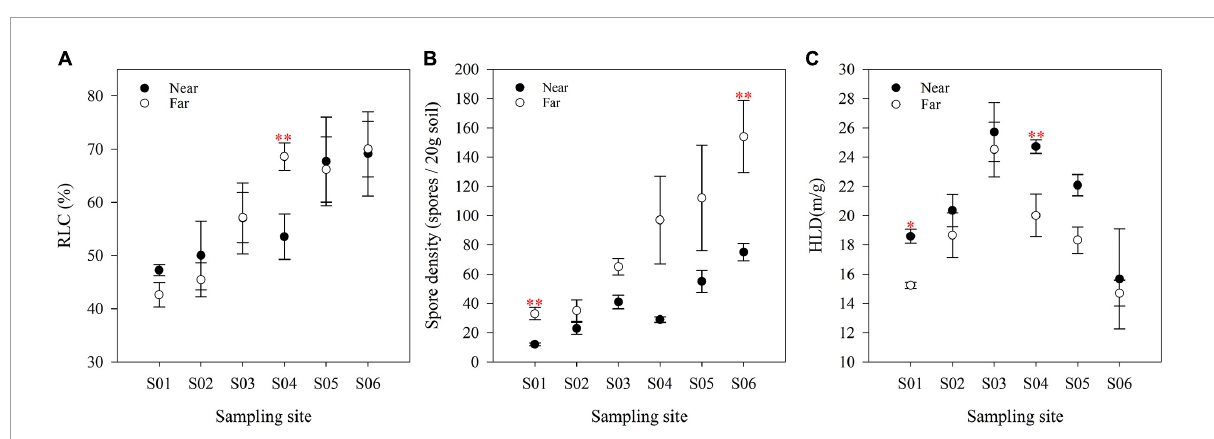
FIGURE3 The relative abundance of each AM fungal genus detected at each sampling site.